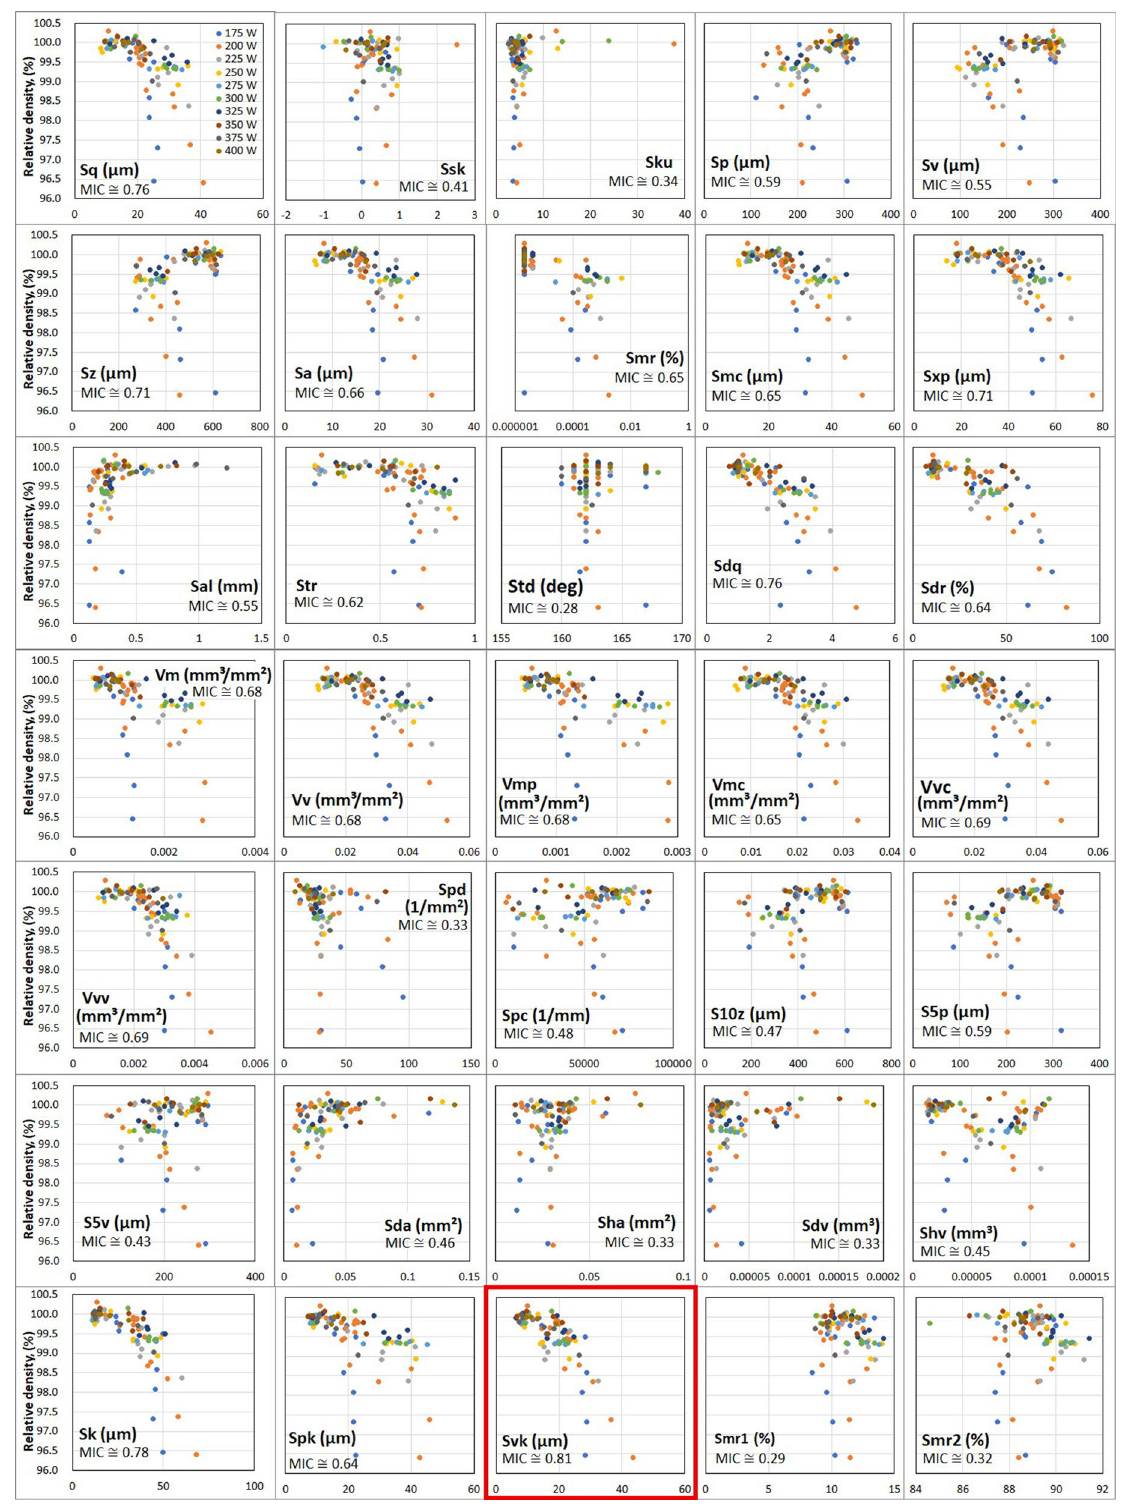
Figure 6. Correlation between 35 areal surface-texture parameters and relative densities of 120 cubic specimens. Images created using Microsoft Office Excel 2019 (https:// www. micro soft. com/ ja- jp/ micro soft- 365/